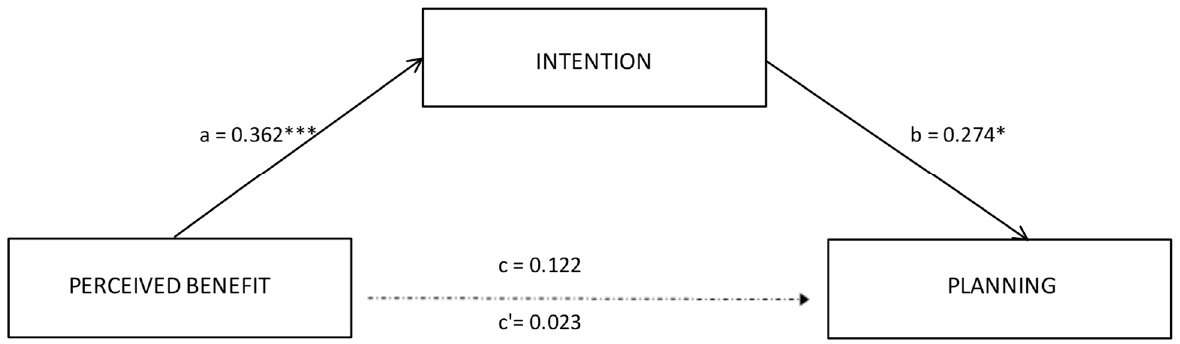
Figure 1. Results of the mediation model. Note: * p < 0.05; *** p <.001. Significant path coefficients are displayed as continuous lines; insignificant paths are displayed as dotted lines. The covariates are not displayed here, they were estimated in the model.